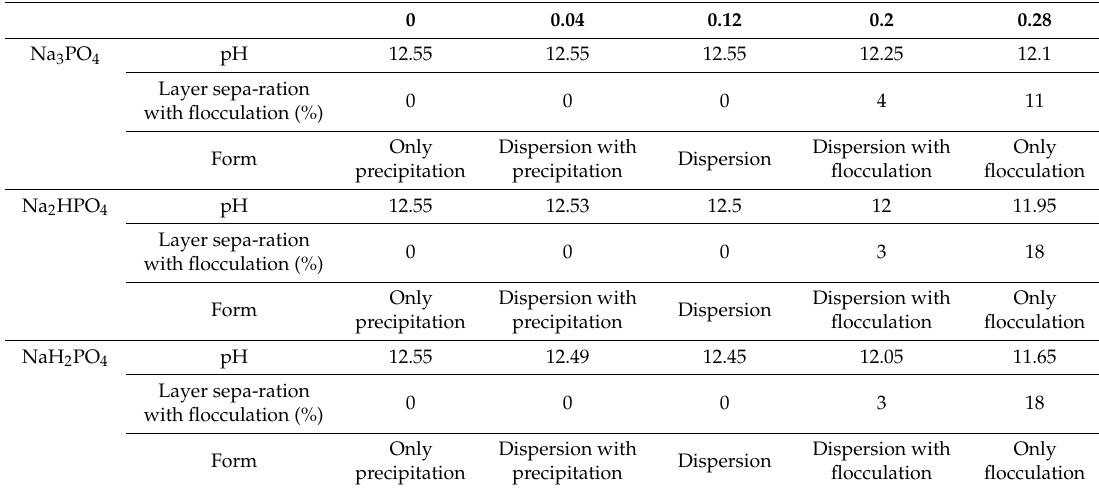
Table 2. Changes in BiSCaO-6 water suspensions by the addition of Na 3 PO 4 , Na 2 HPO 4, or NaH 2 PO 4 .